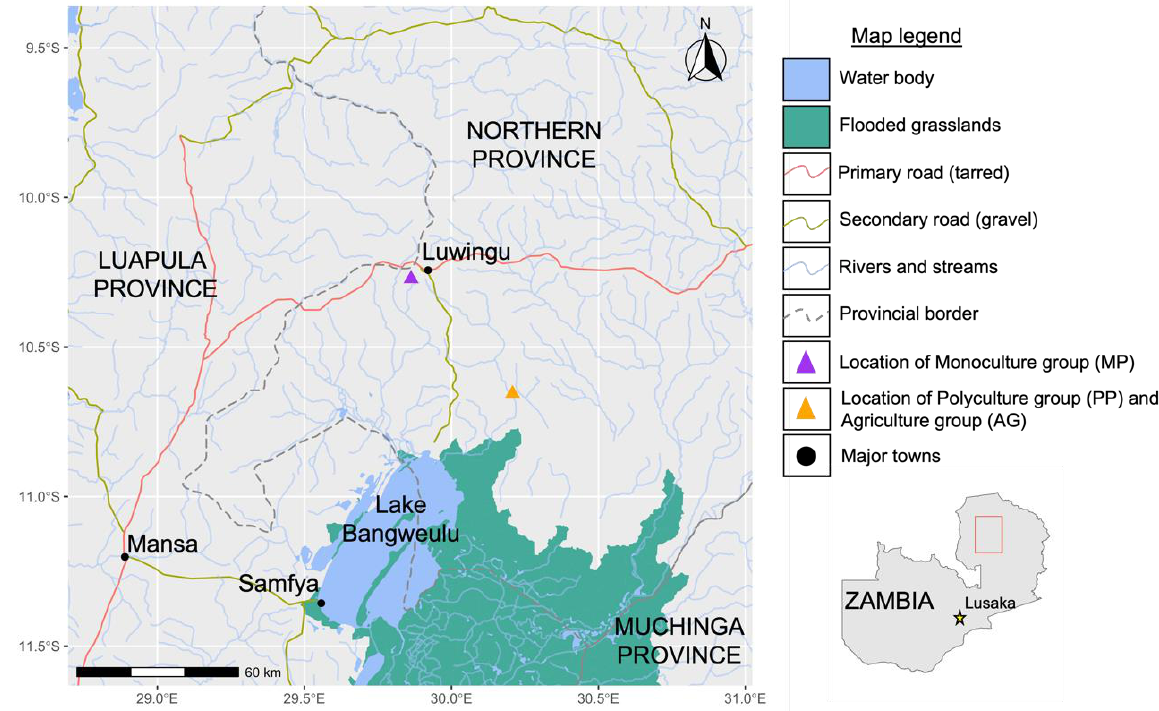
Figure 1. Map of study site locations in Northern Province, Zambia. Data for the flooded grasslands biome is from Terrestrial Ecoregions of the World (TEOW) [41]. Rivers and water bodies are from the HydroATLAS [42])and HydroATLAS-Zambia [43].